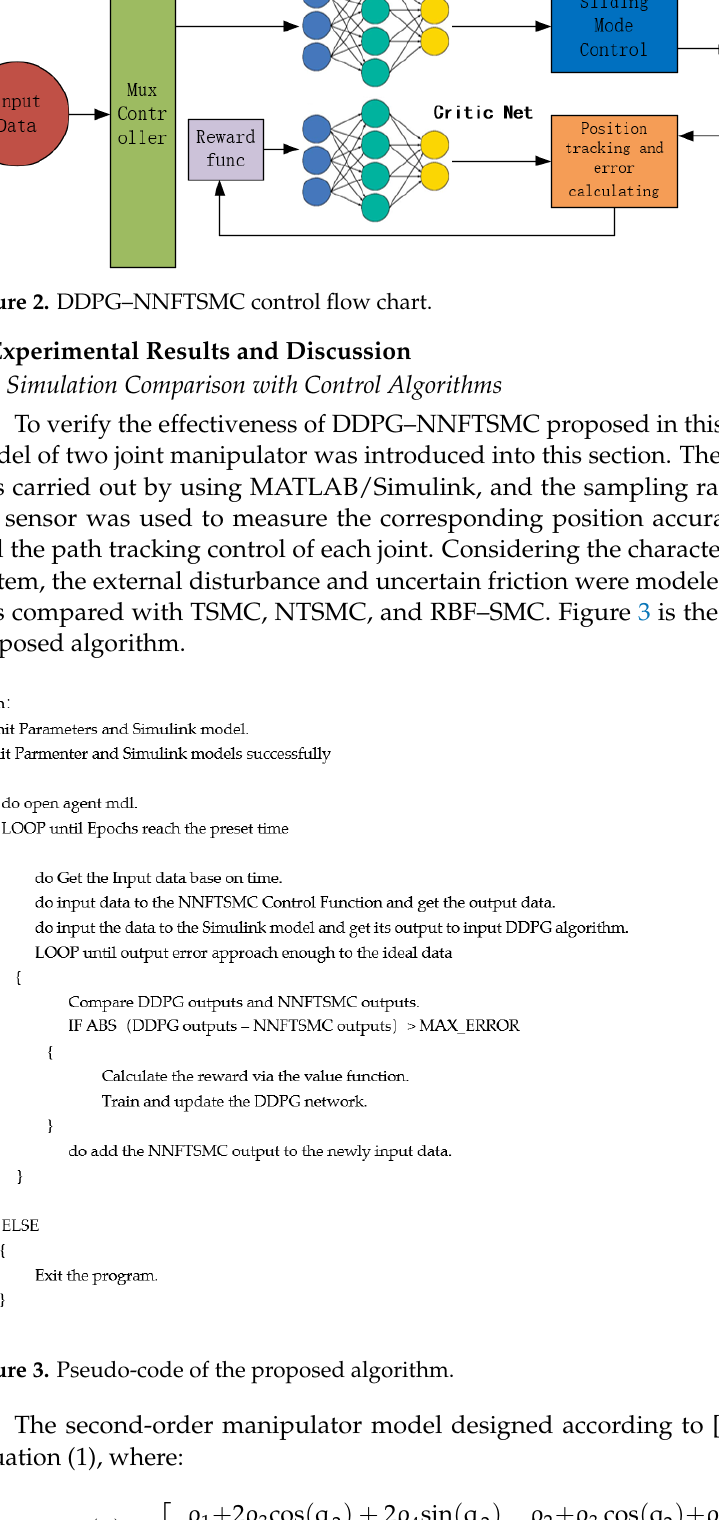
8 of 16 Figure 1. DDPG network control structure chart. Aiming at the two joint control model used in this experiment, two lightweight DDPG networks are used to jointly control the target, which respectively undertakes the